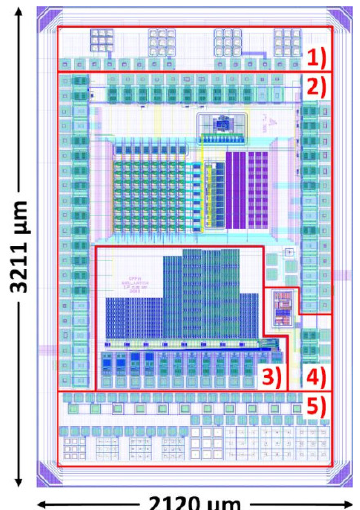
Figure 6. Floorplan of the RD50-MPW2 depleted CMOS sensor with its main blocks highlighted: I–V and E-TCT test structures (1 and 5), 8 by 8 pixel matrix (2), SEU tolerant arrray (3) and bandgap voltage reference